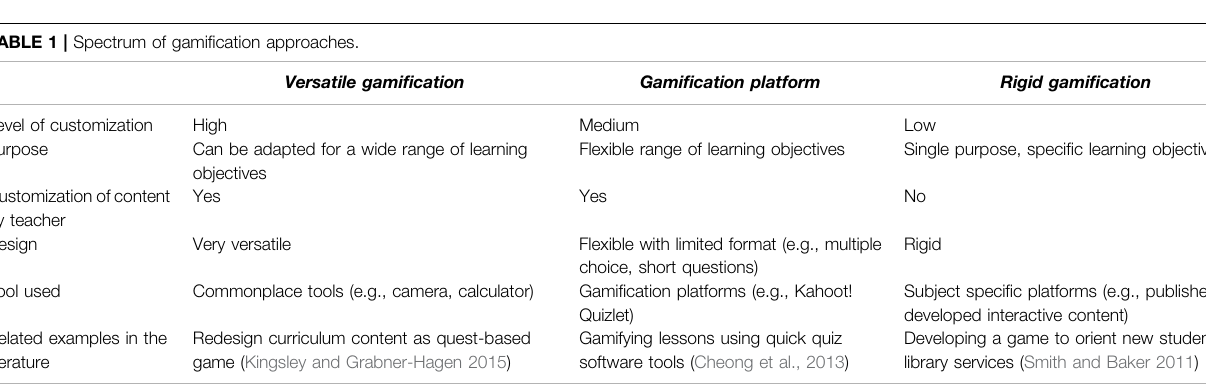
TABLE 1 | Spectrum of gami fi cation approaches.